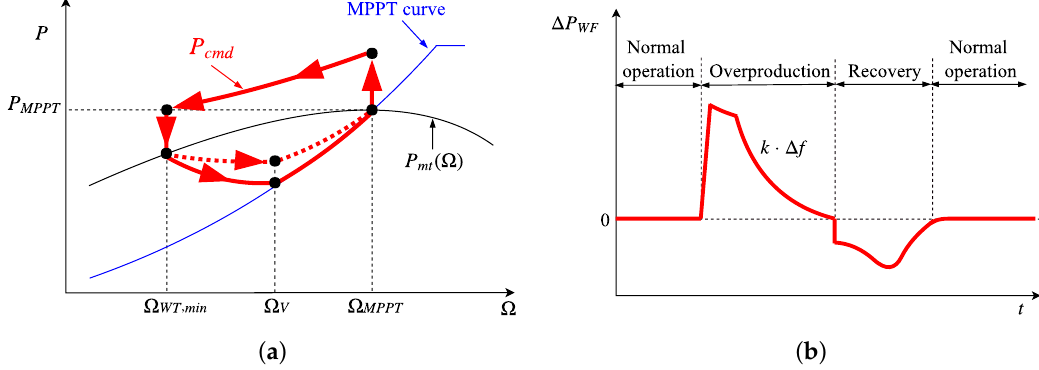
Figure 2. Wind frequency control strategy and VSWTs’ active power variation ( ∆ P WF ) [25]; ( a ) frequency control strategy used for VSWTs; ( b ) ∆ P WF with frequency control strategy.